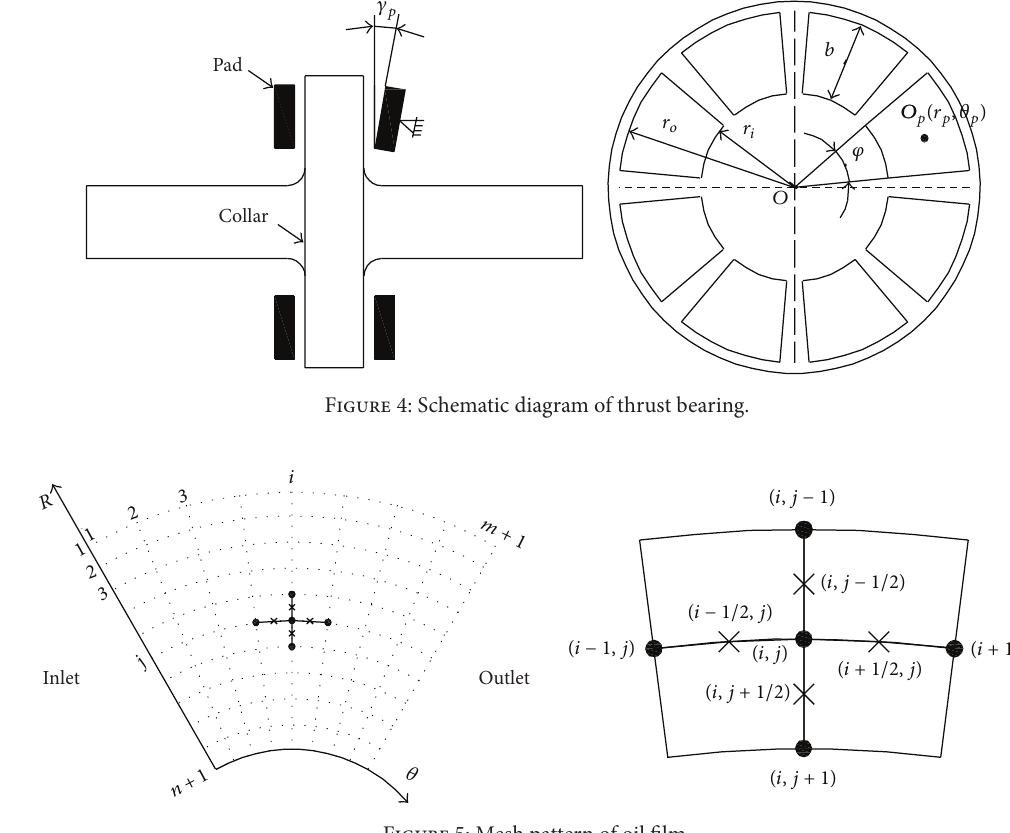
Figure 5: Mesh pattern of oil